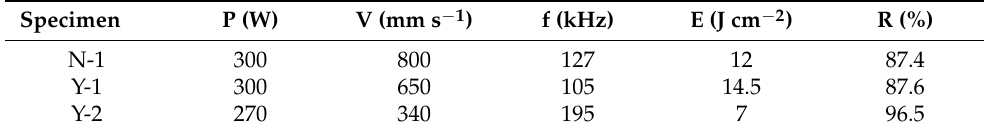
Figure 7. The macroscopic images of the samples before and after laser treatment for ( a ) N-0, ( b ) N-1, ( c ) Y-1, and ( d ) Y-2 samples; ( e ) the spattered coatings residue on the platform after laser removal. Table 3. Laser removal parameters of different specimens.